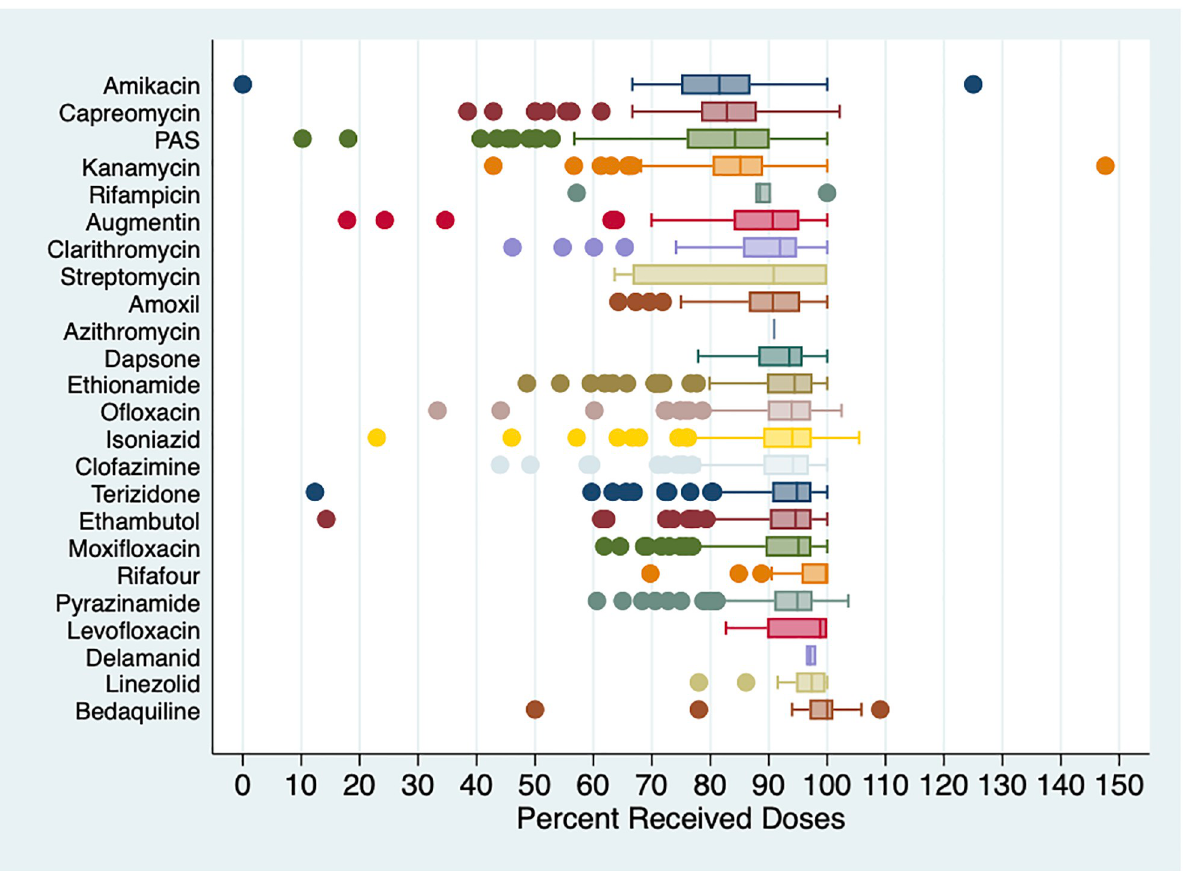
Fig 2. Percent received doses of anti-tuberculosis drugs. Box plots of percent of doses received per patient to anti-tuberculosis drugs during all hospitalizations according to prescription chart records, ordered from lowest to highest median percentage. Values exceeded 100% when number of doses received was greater than number of doses